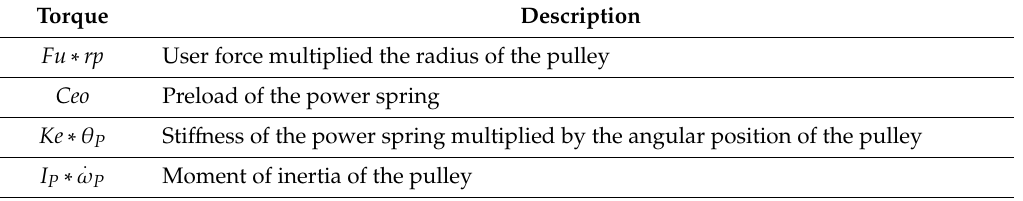
Table 1. Description of the torques in the free-body diagrams.